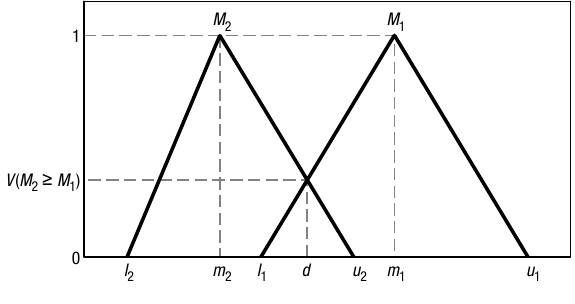
Fig. 2. Intersection of M